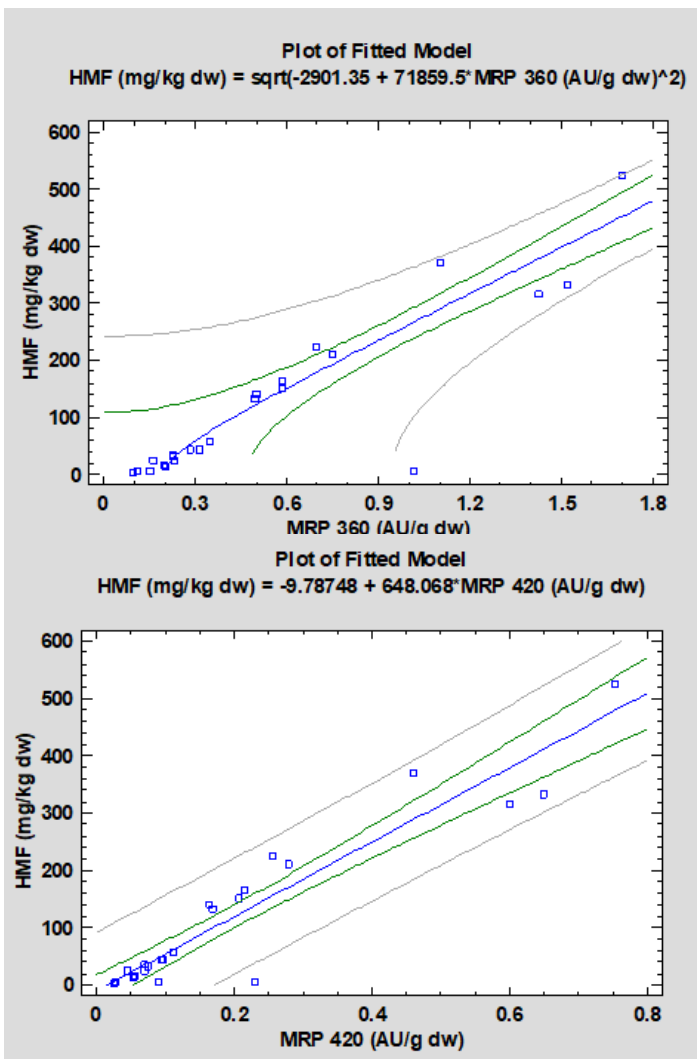
Figure 7. Best fitting regression models for the estimation of 5-hydroxymethylfurfural (HMF) in bread samples as a function of colour and spectrophotometric indices. BI, browning index; IM, Intensity mean; MRP 280, Maillard reaction products evaluated at 280 nm; MRP 360, Maillard reaction products evaluated at 360 nm; MRP 420, Maillard reaction products evaluated at 420 nm.